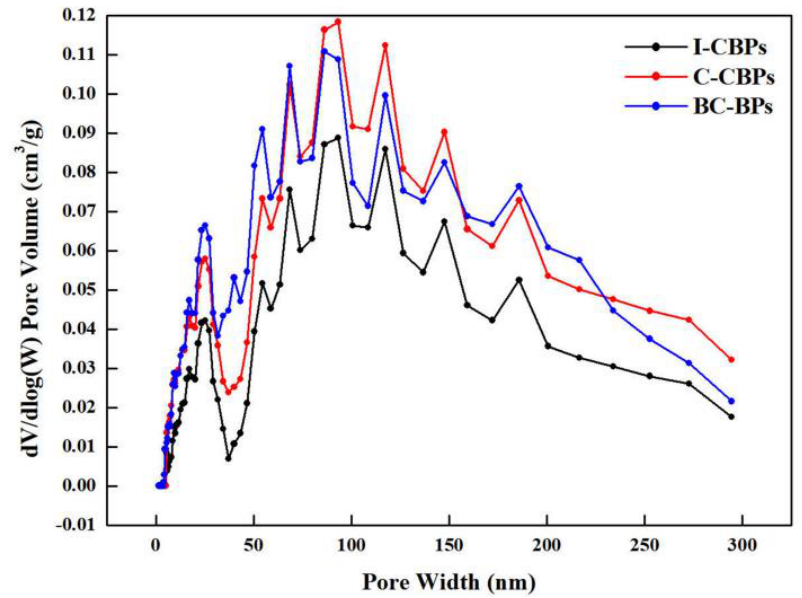
Figure 9. Results of BET DFT and the filling effect of different morphologies of MWCNTs on the pore space.